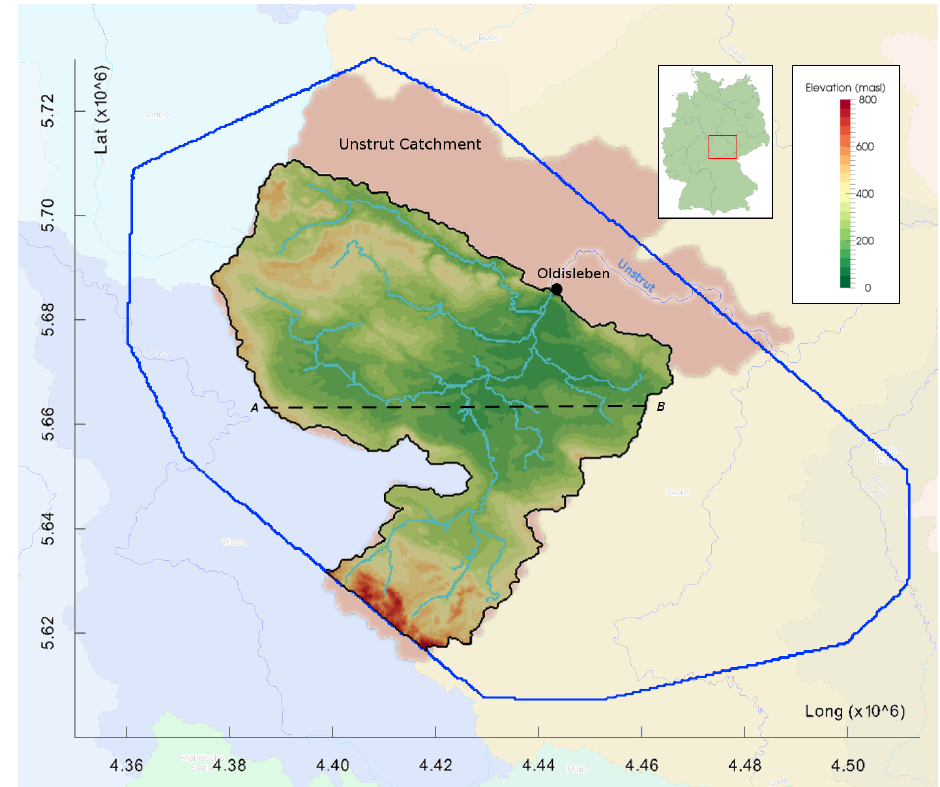
Figure 1. Overview map of the Thuringian Syncline region: border of the GOCAD geological model (blue line), elevation and rivers (light blue) in the simulation model of the Unstrut catchment until the Oldisleben gauge (border as black line), position of cross section A–B (dashed line); background catchment map from the BFN (2015), digital elevation data from the SRTM (Shuttle Radar Topography Mission) (Jarvis et al., 2008), Germany overview map from Wikimedia Commons